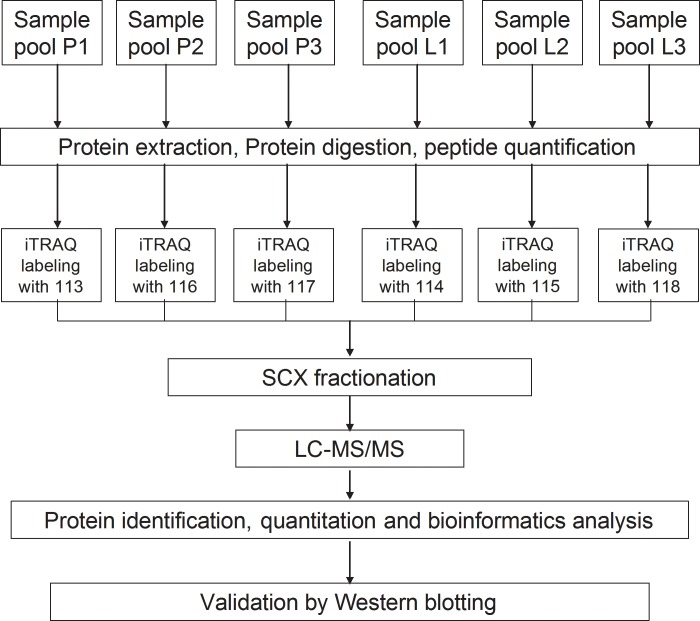
Experimental design and schematic diagram of the workflow used in this study.